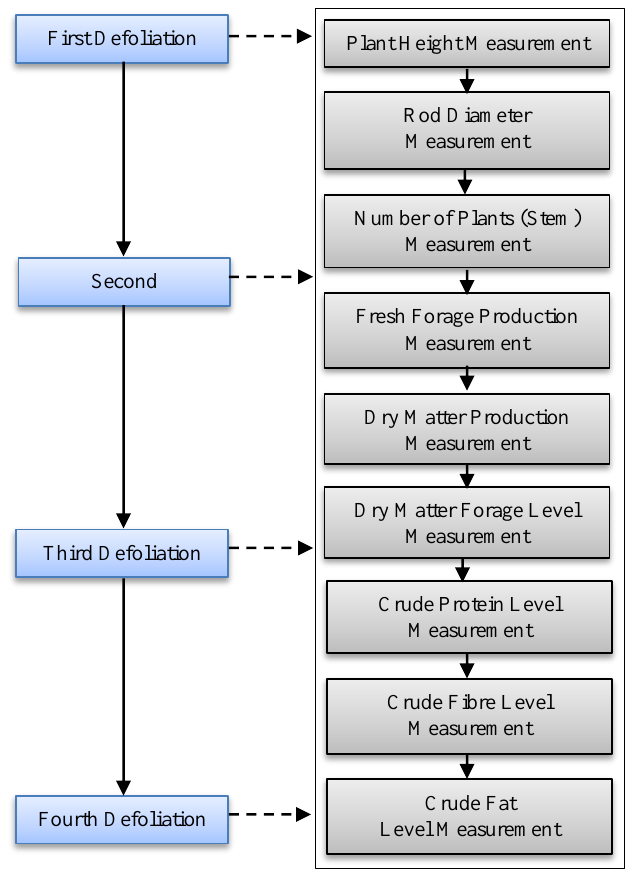
Figure 1. Flowchart of the Research